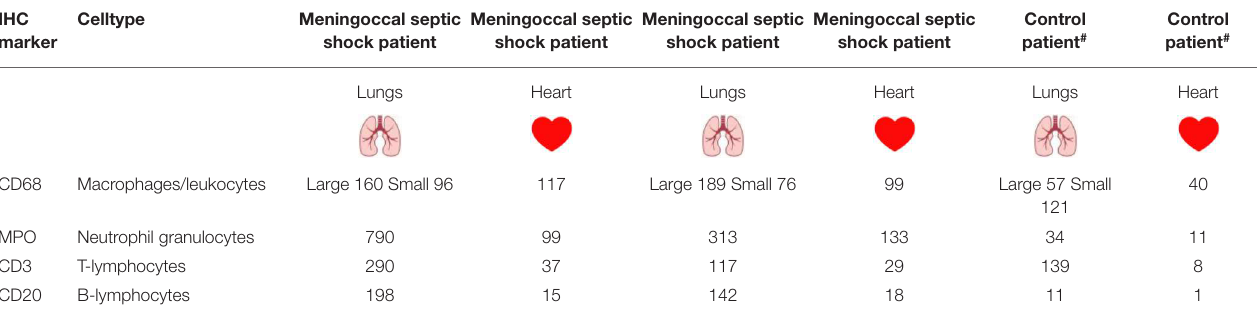
TABLE 2 | Immunohistochemically examination of FFPE tissue samples (lungs and heart) from two patients with meningococcal septic shock and one control patient (acute non-infectious death). IHC Celltype marker